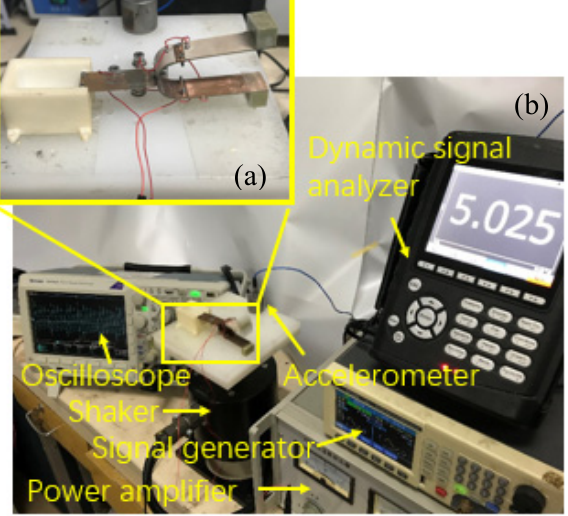
Figure 7. Experimental prototype and test system. ( a ) The physical picture of the experimental prototype; ( b ) tuning fork piezoelectric energy harvester and a complete test system.